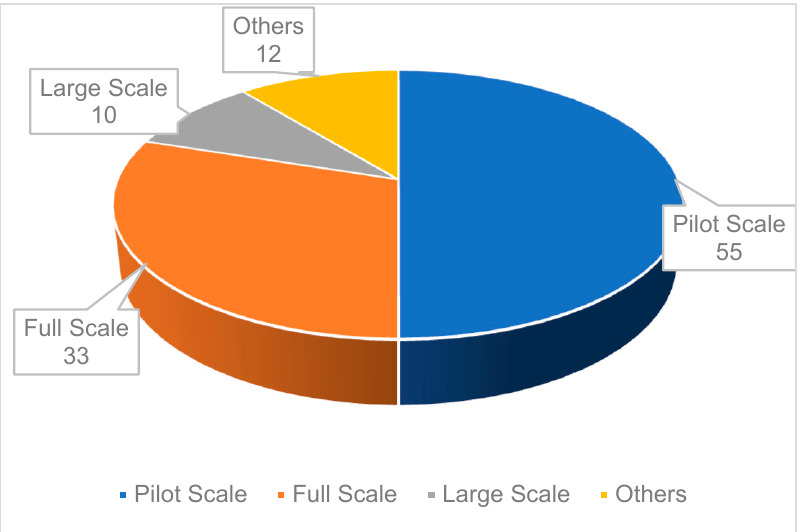
Figure 2. Break-down of papers based on the GR scale.